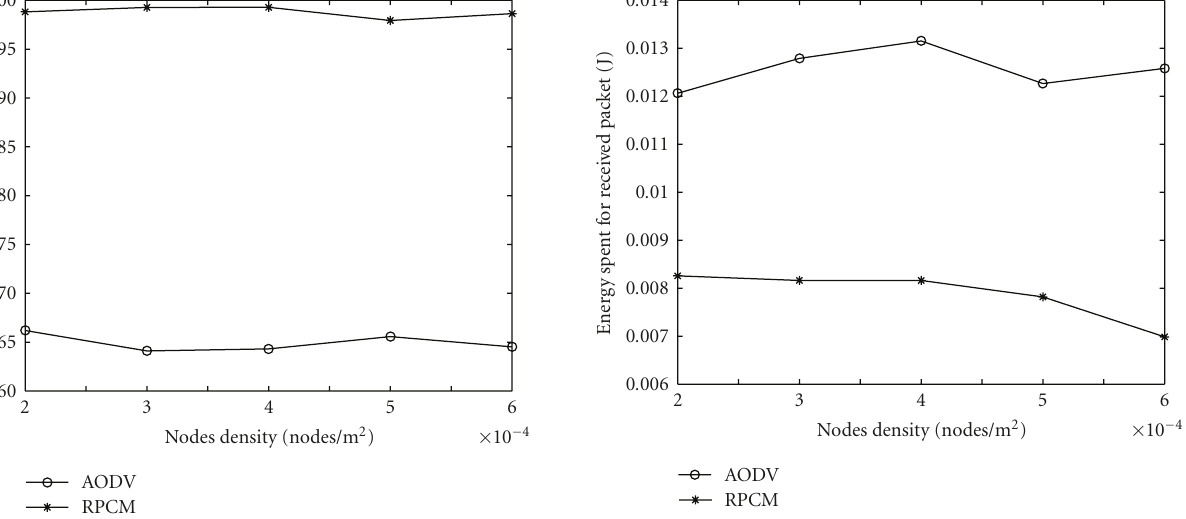
Figure 6: Performance of AODV and RPCM in terms of through- put, when f = 6.